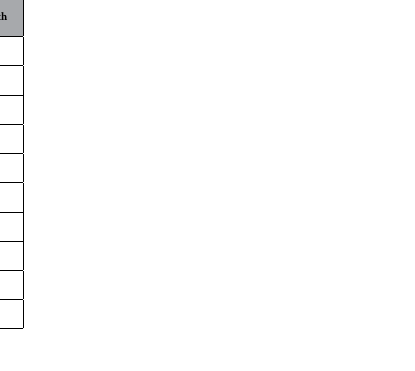
Table 1. Study population